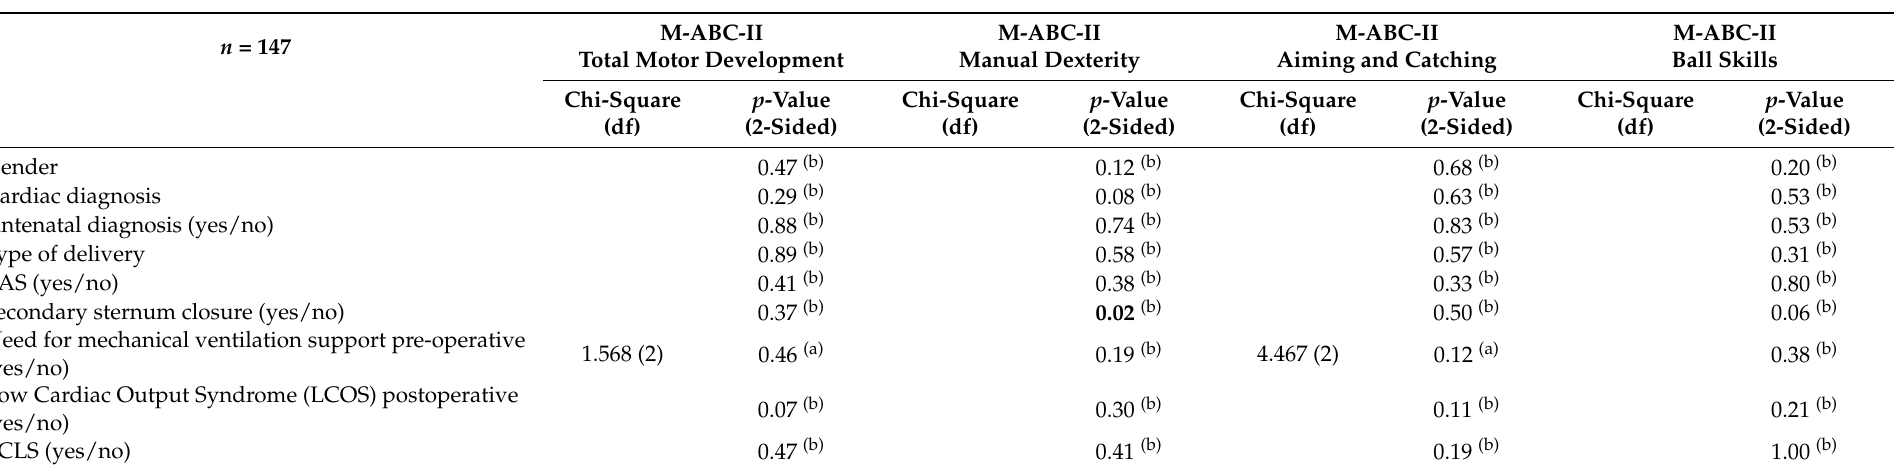
Table A3. Correlations between motor classification and selected risk